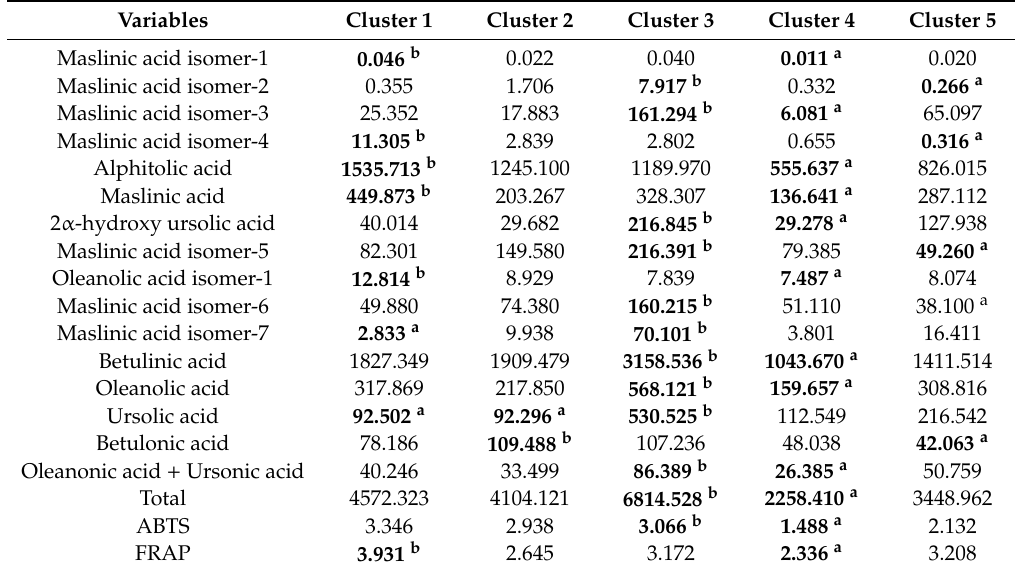
Figure 5. Hierarchical cluster analysis (HCA) of 99 cultivars of jujube samples. Cultivar lines with the same color are in the same cluster. Table 5. The mean values of the detected compounds in different clusters.